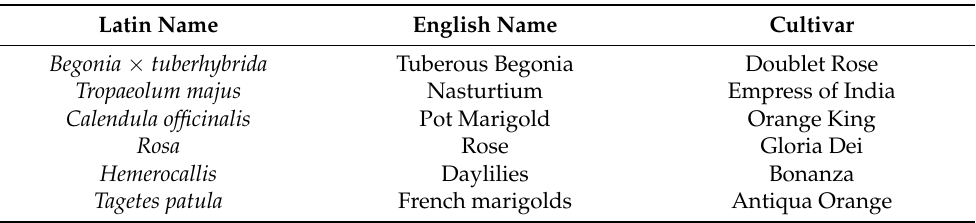
Table 2. Species and cultivars of edible flowers used in the present